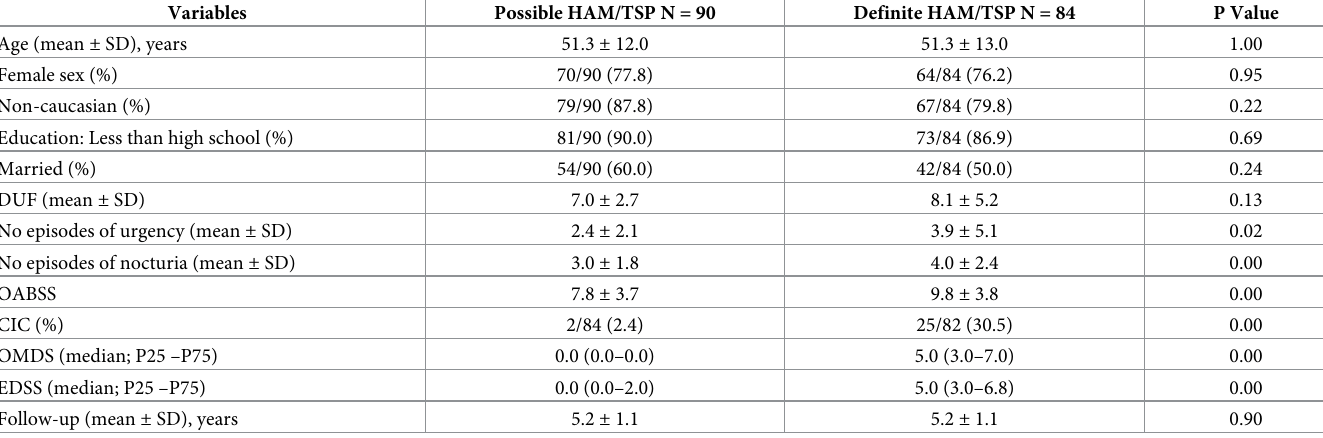
Table 1. Baseline Clinical and Demographic Features of HTLV-1 Infected Patients with Possible and Definite HTLV-1 Associated Myelopathy Followed in a Cohort Study.